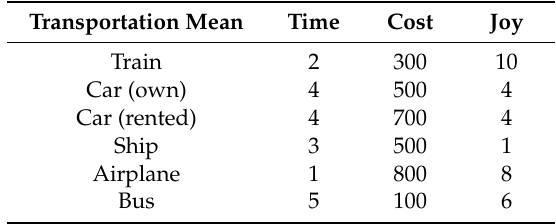
Table 1. Dataset of travel options.